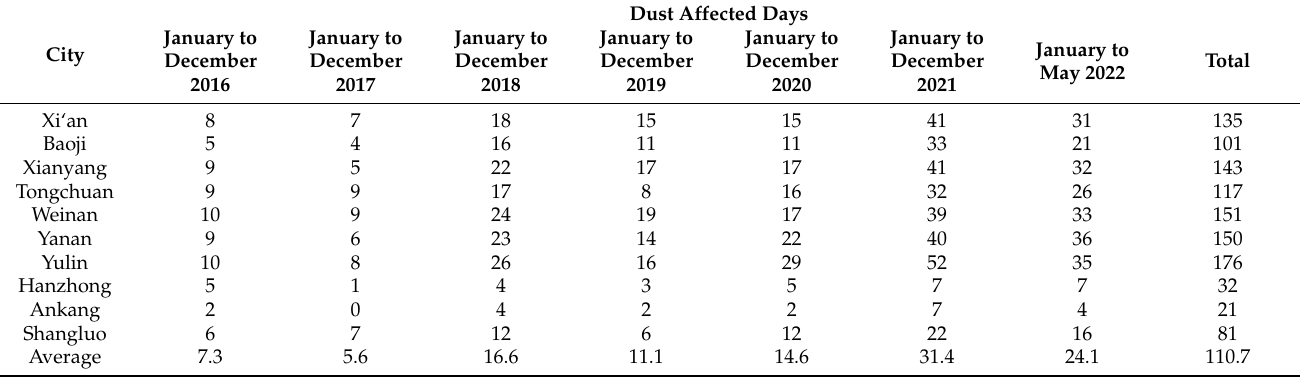
Table 6. Dust days of 10 cities in Shaanxi Province from 2016 to 2022 by using MDPD-k-means method.